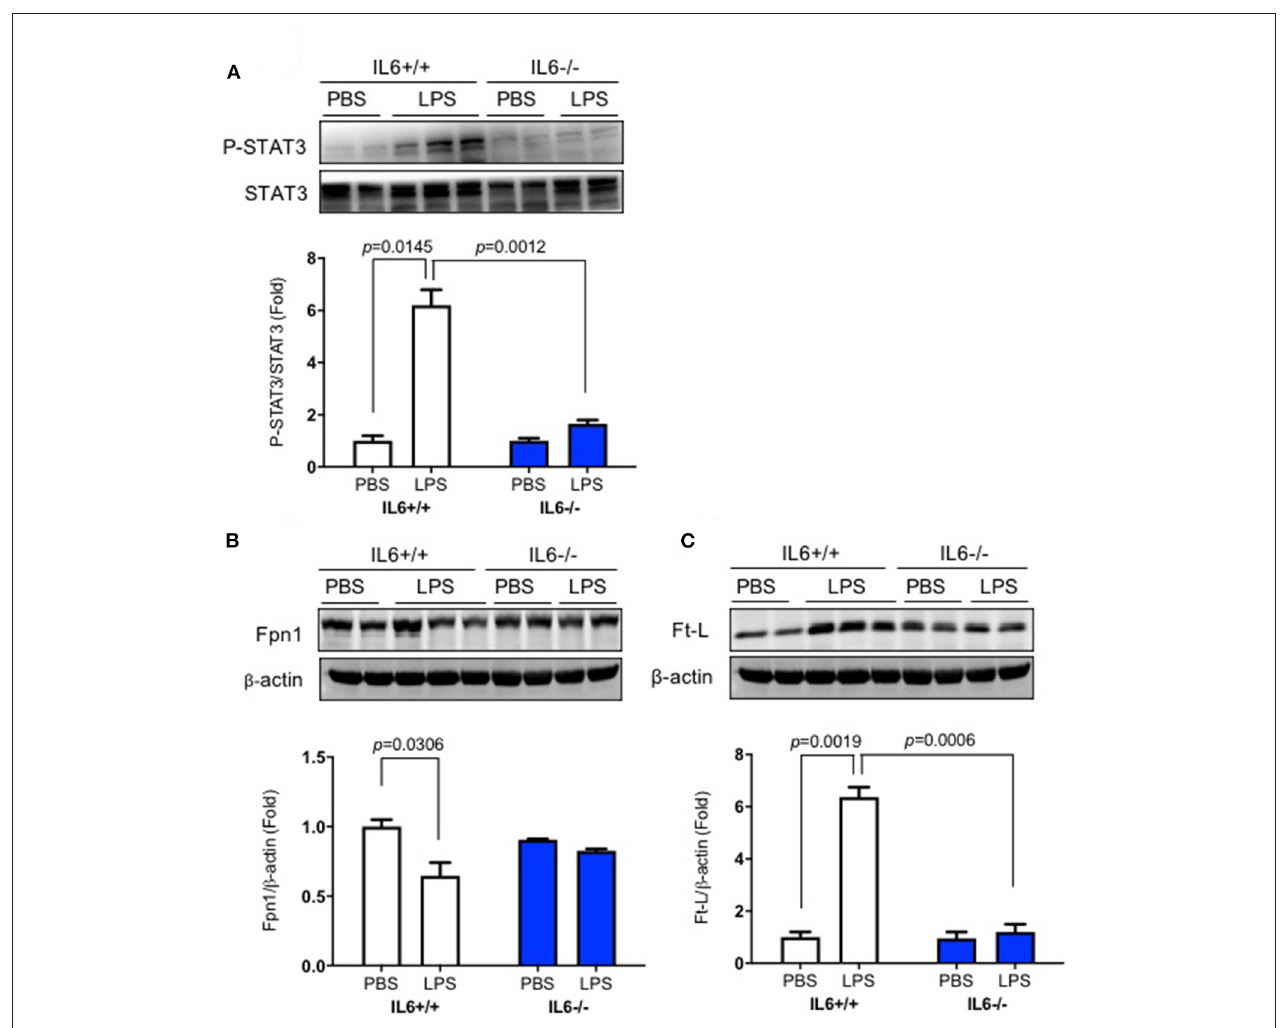
FIGURE 3 | IL-6 deficiency eliminated the decrease of Fpn1 and the increase of p-STAT3 and Ft-L protein induced by lipopolysaccharide (LPS) in the liver. IL-6 + / + and IL6–/– mice were administered with phosphate-buffered saline (PBS) or LPS intracerebroventricular (ICV) injection. At 6h after LPS treatment, p-STAT3 (A) , Fpn1 (B) , and Ft-L (C) protein expression levels in the liver were detected using western blot. Data are presented as means ± SEM (% control) (IL-6 + / + : PBS = 3, LPS = 6; IL-6–/–: PBS = 3, LPS = 3). Analysis between the treatments was done via two-way ANOVA with Sidak’s post hoc